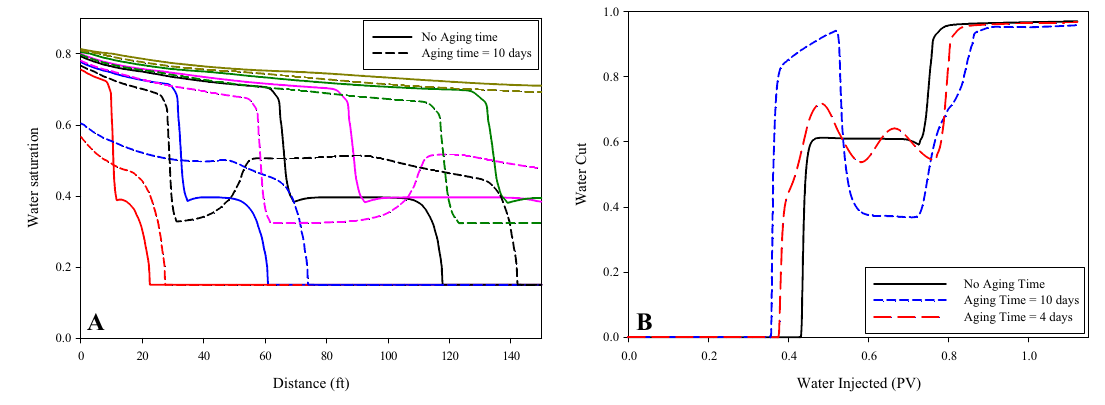
Fig. 13 a The water saturation profile during LSW flooding with the aging time of 10 days and without aging time [red: 0.056 PV (2.5 days), blue: 0.165 PV (7.5 days), black: 0.33 PV (15 days), pink: